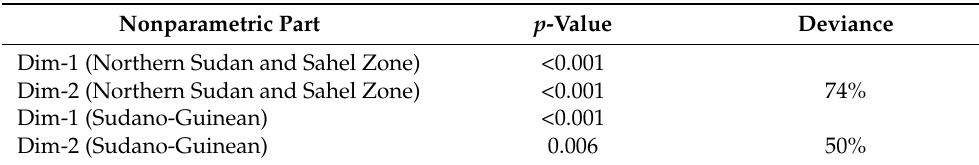
Table 4. Multivariate analysis between the meteorological axis and malaria incidence with General Additive Model